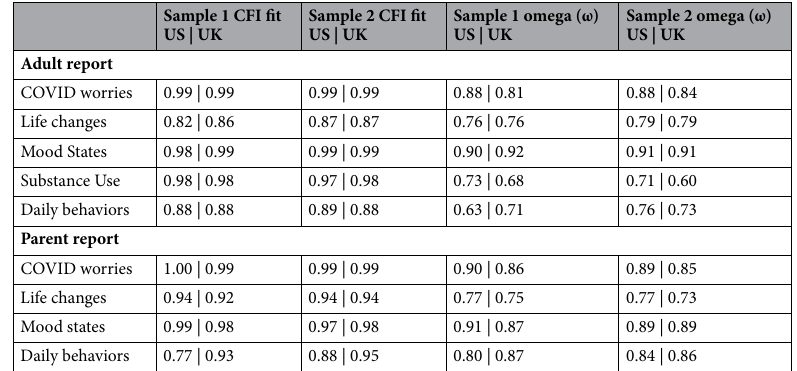
Table 2. Fit statistics from confirmatory factor analysis in split-half samples from adult self-report and parent respondents in the US and